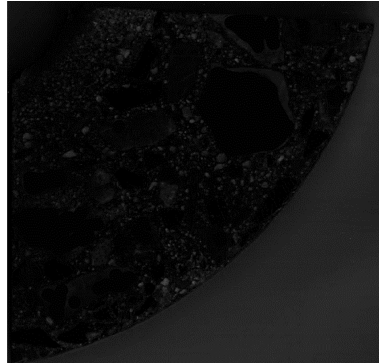
Figure 9. Superimposition of masks created from red (R) and blue (B) channels.